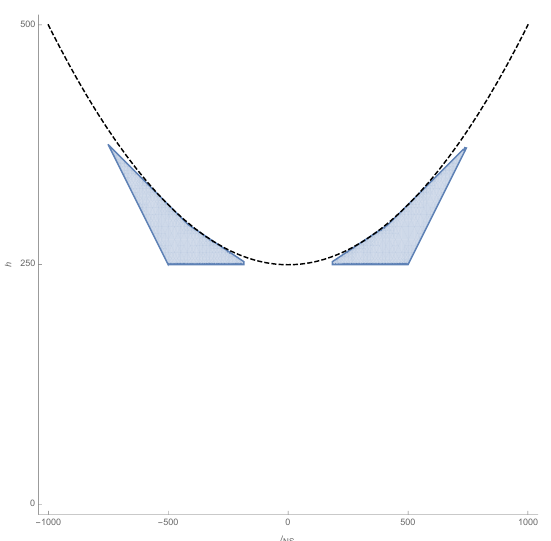
Figure 4 . Non-vanishing states in region (5.34) and (5.46) for t = 2 and m = 1000. The dashed line is the boundary between polar and non-polar